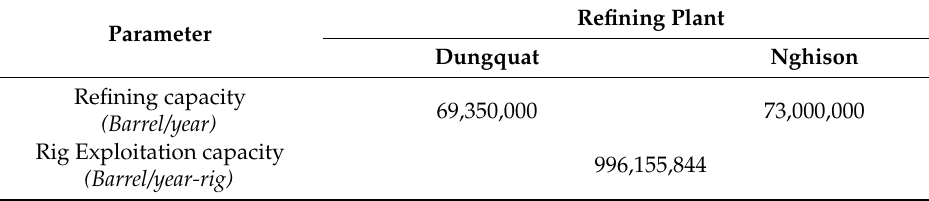
Table A5. Production-related parameter value.